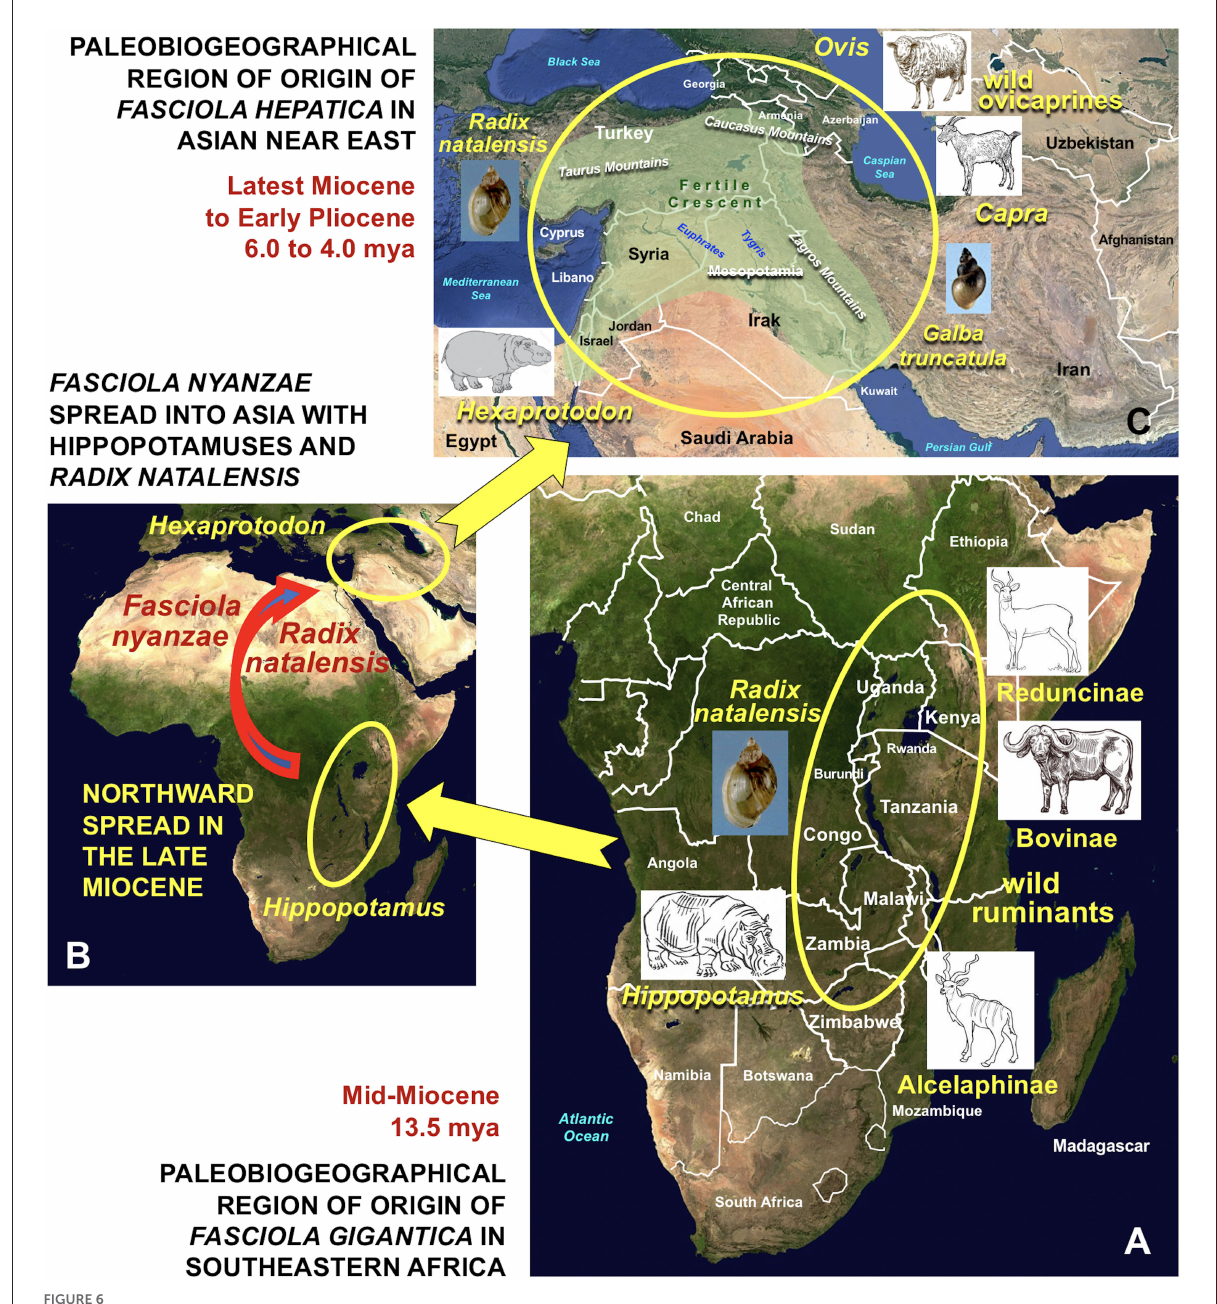
FIGURE6 Paleobiogeographical regions of origin of Fasciola gigantica and F. hepatica by direct evolutionary derivation from F. nyanzae infecting past hippopotamuses. (A) Origin of F. gigantica in southeastern Africa by definitive host capture phenomenon from African past hippopotamuses to wild ruminants, mainly ancestors of the bovid subfamilies Reduncinae, Bovinae and Alcelaphinae by keeping the same snail vector Radix natalensis in the Mid-Miocene, around 13.5 mya; (B) northward spread of F. nyanzae with African hippopotamuses and R. natalensis and introduction from Africa into the Asian Near East with Hexaprotodon in the Late Miocene, around 6.1 and 5.9 mya; (C) origin of F. hepatica in Near East Asia by definitive host capture phenomenon from Hexaprotodon to wild species of ovicaprines of the genera Ovis and Capra and vector capture event from R. natalensis to Galba truncatula in the Latest Miocene to Early Pliocene, around 6.0–4.0 mya. Countries and geographic names are only those noted in the text. Geographic background from composed satellite maps of orthographic projections by NASA (public domain) via Wikimedia Commons. Schema S.